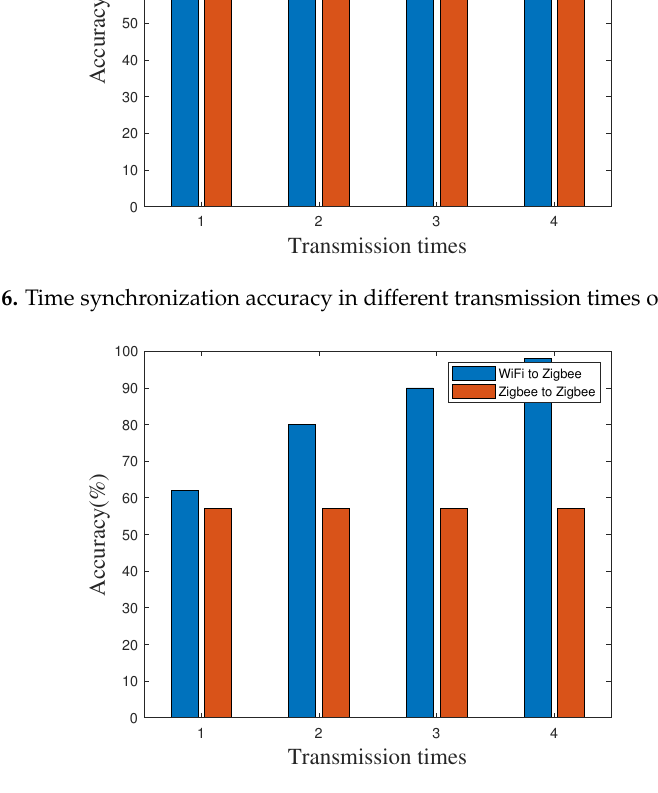
Figure 7. Time synchronization accuracy in different transmission times